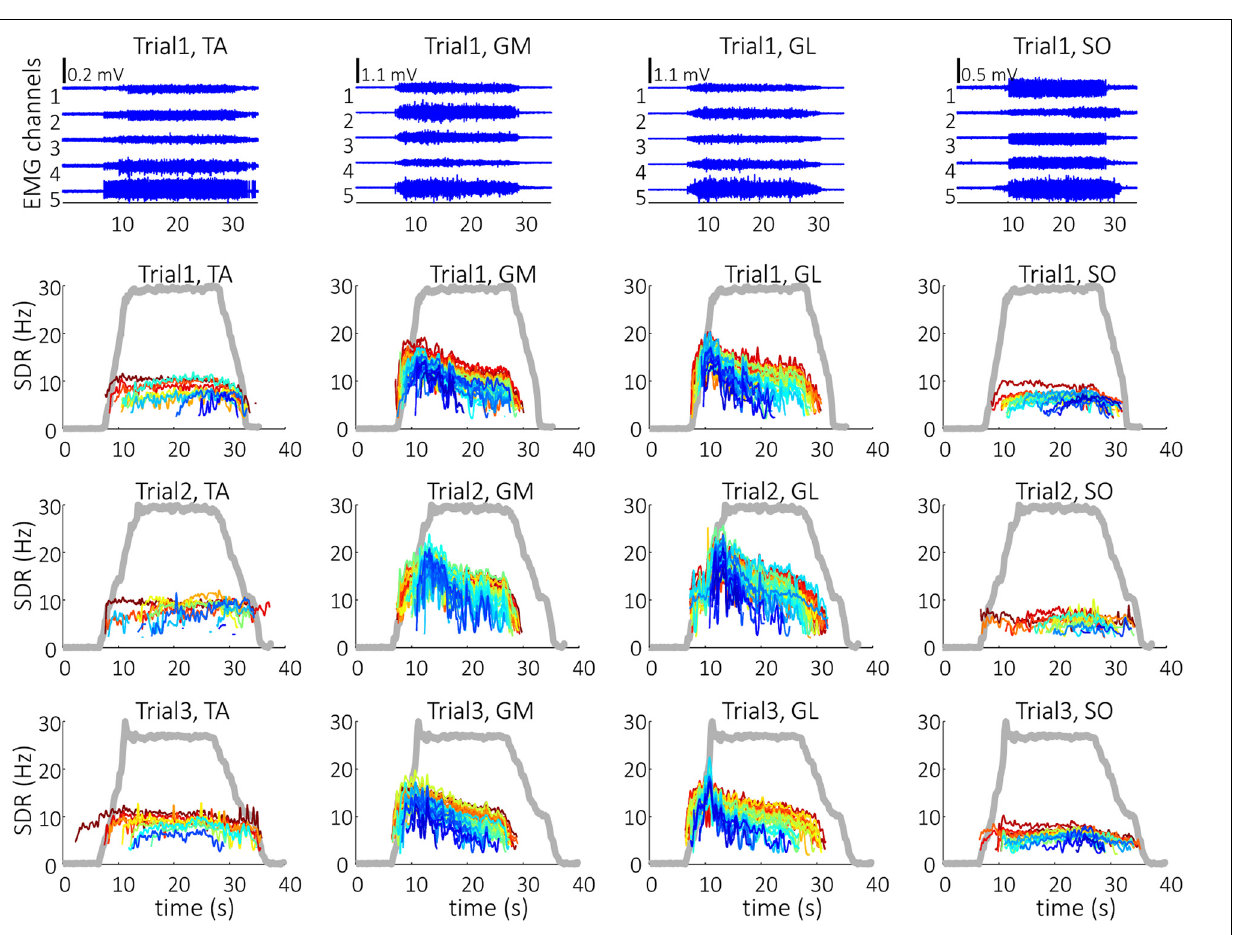
FIGURE 3 | Single differential hdEMG channels (top panels) and smoothed discharge rates (SDR) of individual motor units (panels in the three bottom rows), as identified from the hdEMG signals of older participant (O1). The three trials were performed before the bed rest at 30% MVC torque. TA, Tibialis anterior; GM, Gastrocnemius medialis; GL, Gastrocnemius lateralis; SO, Soleus. The thick gray line represents the measured muscle